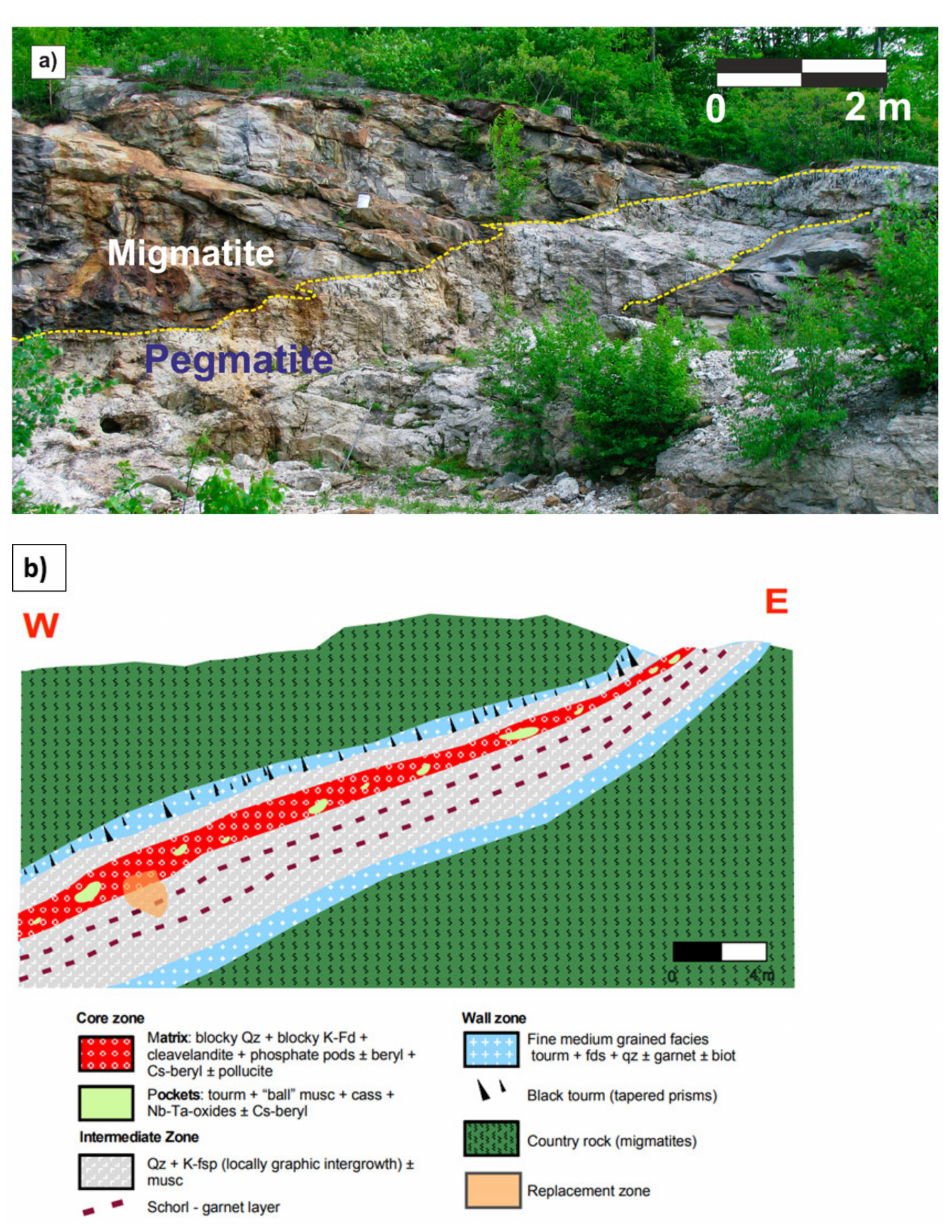
Figure 7. ( a ) General view of the Emmons pegmatite quarry, where it is possible to see the con- tacts between the pegmatite and the hosting migmatite; ( b ) Idealized cross-section of the Emmons pegmatite (modified from Roda-Robles in